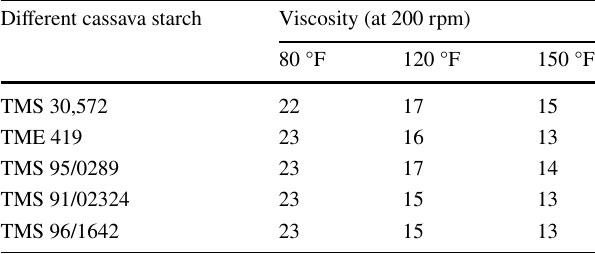
Table 8 Mud samples from different cassava starch (Ademiluyi et al. 2011)